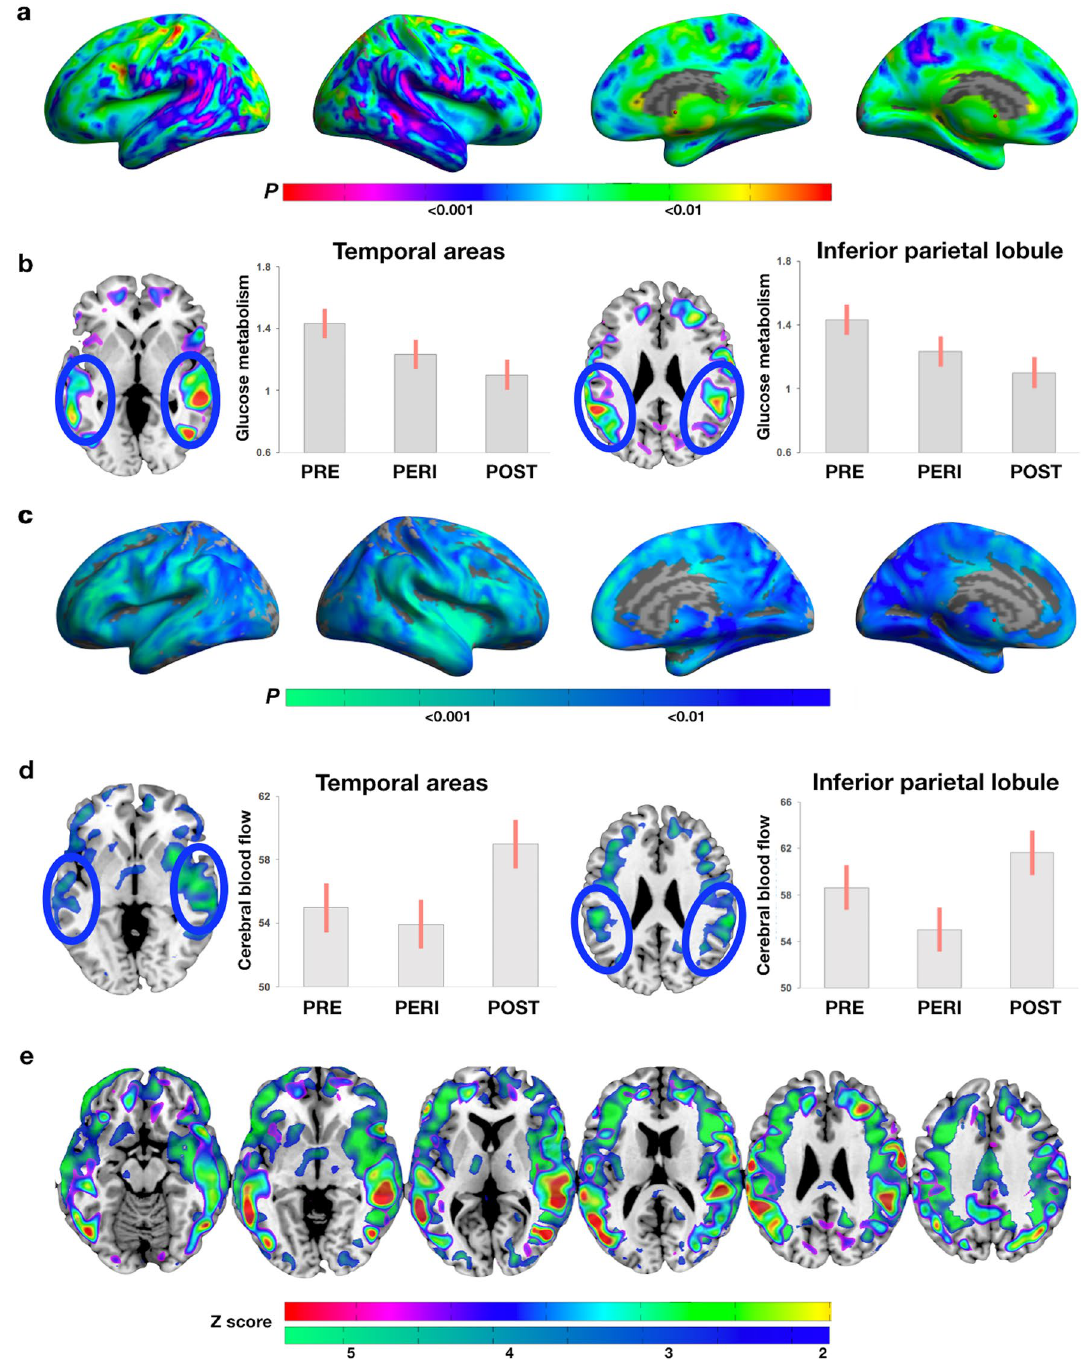
Figure 2. Metabolic biomarker differences between menopausal groups. ( a ) Surface maps of regional CMRglc differences. ( b) MRI slice overlays and plots representing CMRglc in temporal and parietal regions. ( c ) Surface maps of regional CBF differences. ( d ) MRI slice overlays and plots representing CBF extracted in temporal and parietal clusters. ( e ) Slice overlays depicting the overlap between CMRglc (green to red scale) and CBF (blue to green scale) effects. ( f ) In ( a , c ), SPMs are represented on modality-specific color-coded scales with corresponding p values. In ( e ), Z scores are reported to enable multi-modality comparisons. In ( b , d ), values are mean (SE). Results are adjusted by age and global activity. Abbreviations CBF, cerebral blood flow; CMRglc, cerebral glucose metabolism; PERI, peri-menopause; POST, post-menopause; PRE, pre-menopause; SPMs, statistical parametric